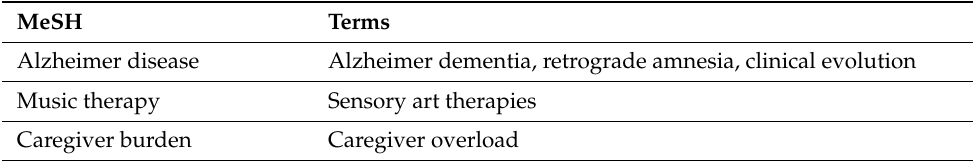
Table 1. Terms used in the